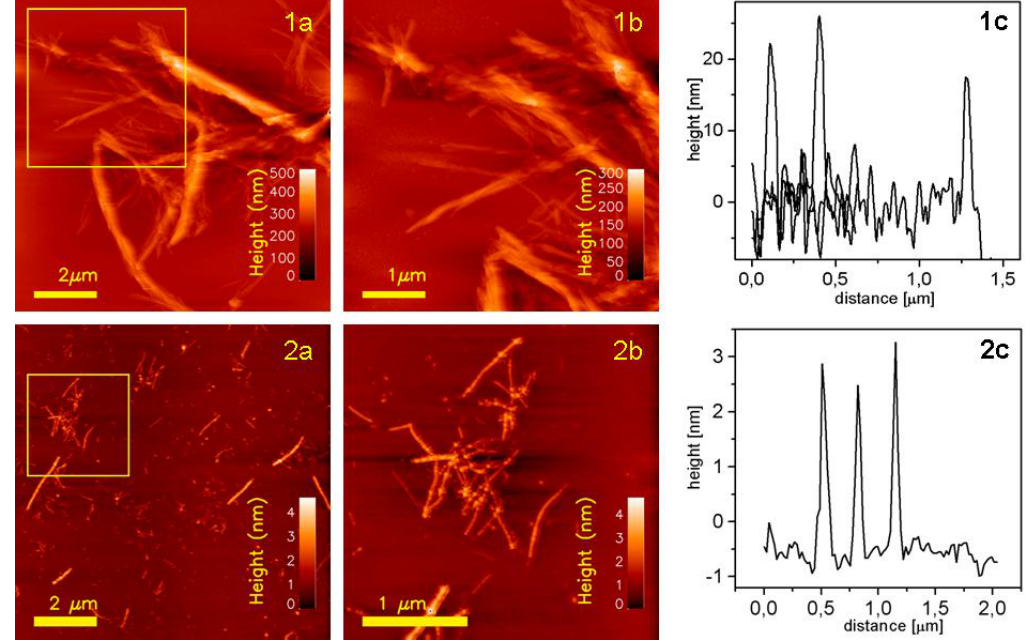
Figure 5. AFM topographs of insulin amyloids in dry state: ( 1 ) fibrils deposited onto gold-mica surface and ( 2 ) filaments anchored to the silane-mica. The yellow frames in 1a and 2a are zoomed in 1b and 2b, respectively. Plots 1c and 2c show representative height profiles from images 1b and 2b,